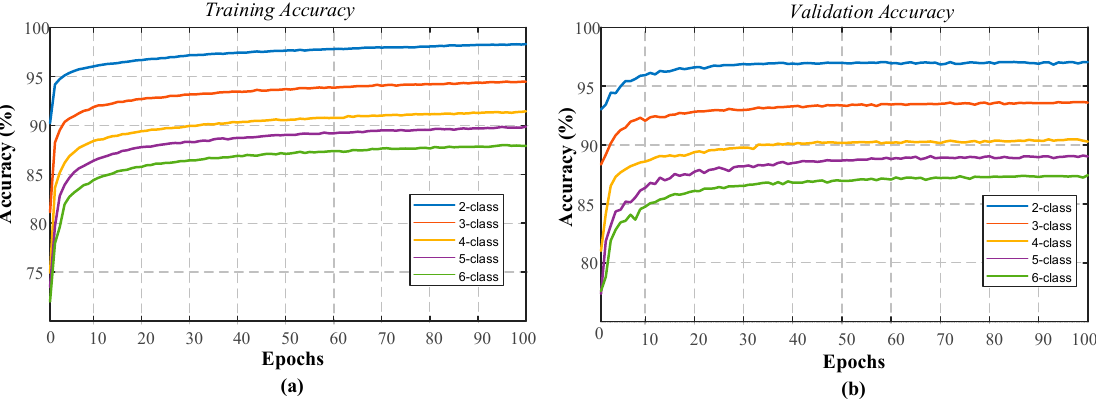
Figure 9. Training performance graphs obtained for different classes when the proposed model used the single-channel EOG from the sleep-edfx database: ( a ) training accuracy and ( b ) validation accuracy.